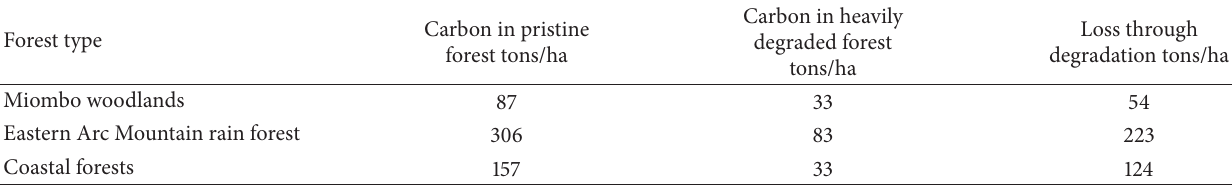
Table 5: Carbon stock for pristine and degraded forest types of